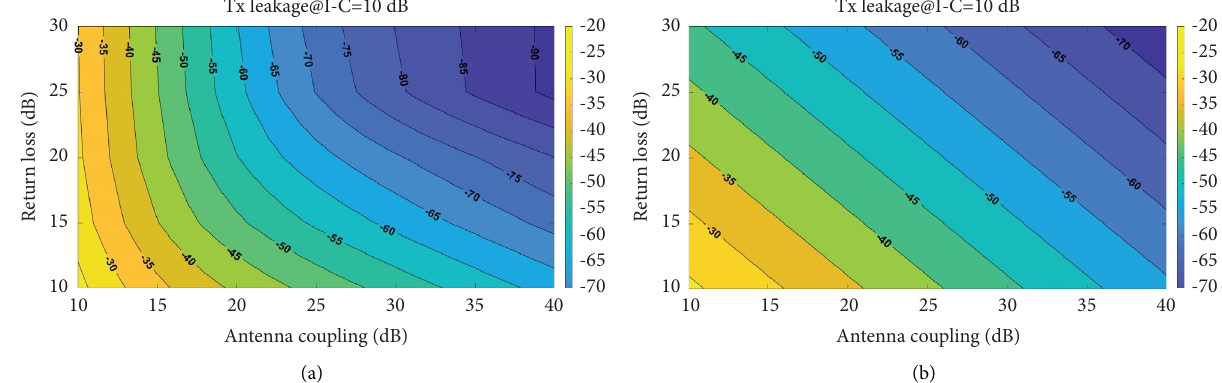
Figure 5: Tx leakage levels against the antenna coupling and return loss of the Tx and Rx antennas with I − C � 10dB from (a) equation (7) and (b) equation